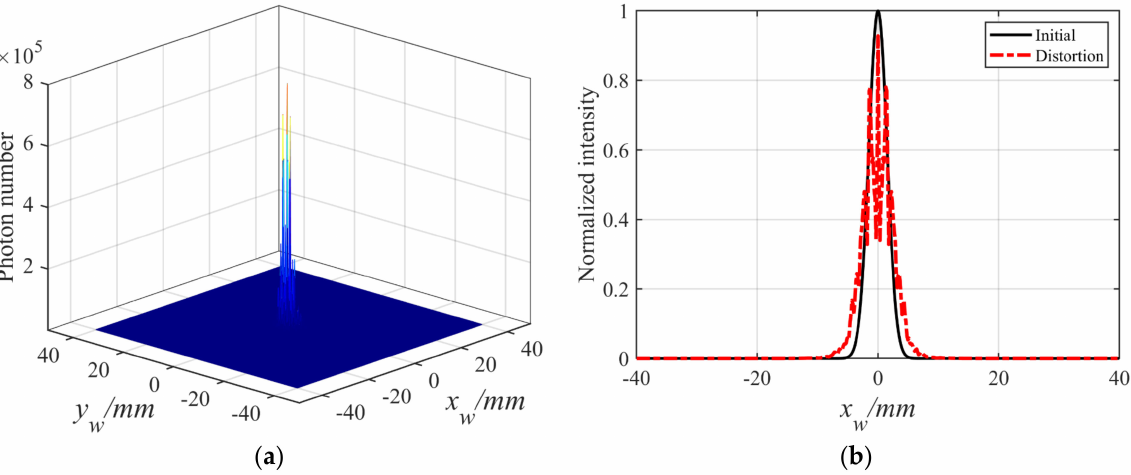
Figure 13. ( a ) Photon reception intensity at the optical window; ( b ) comparison of normalized photon reception